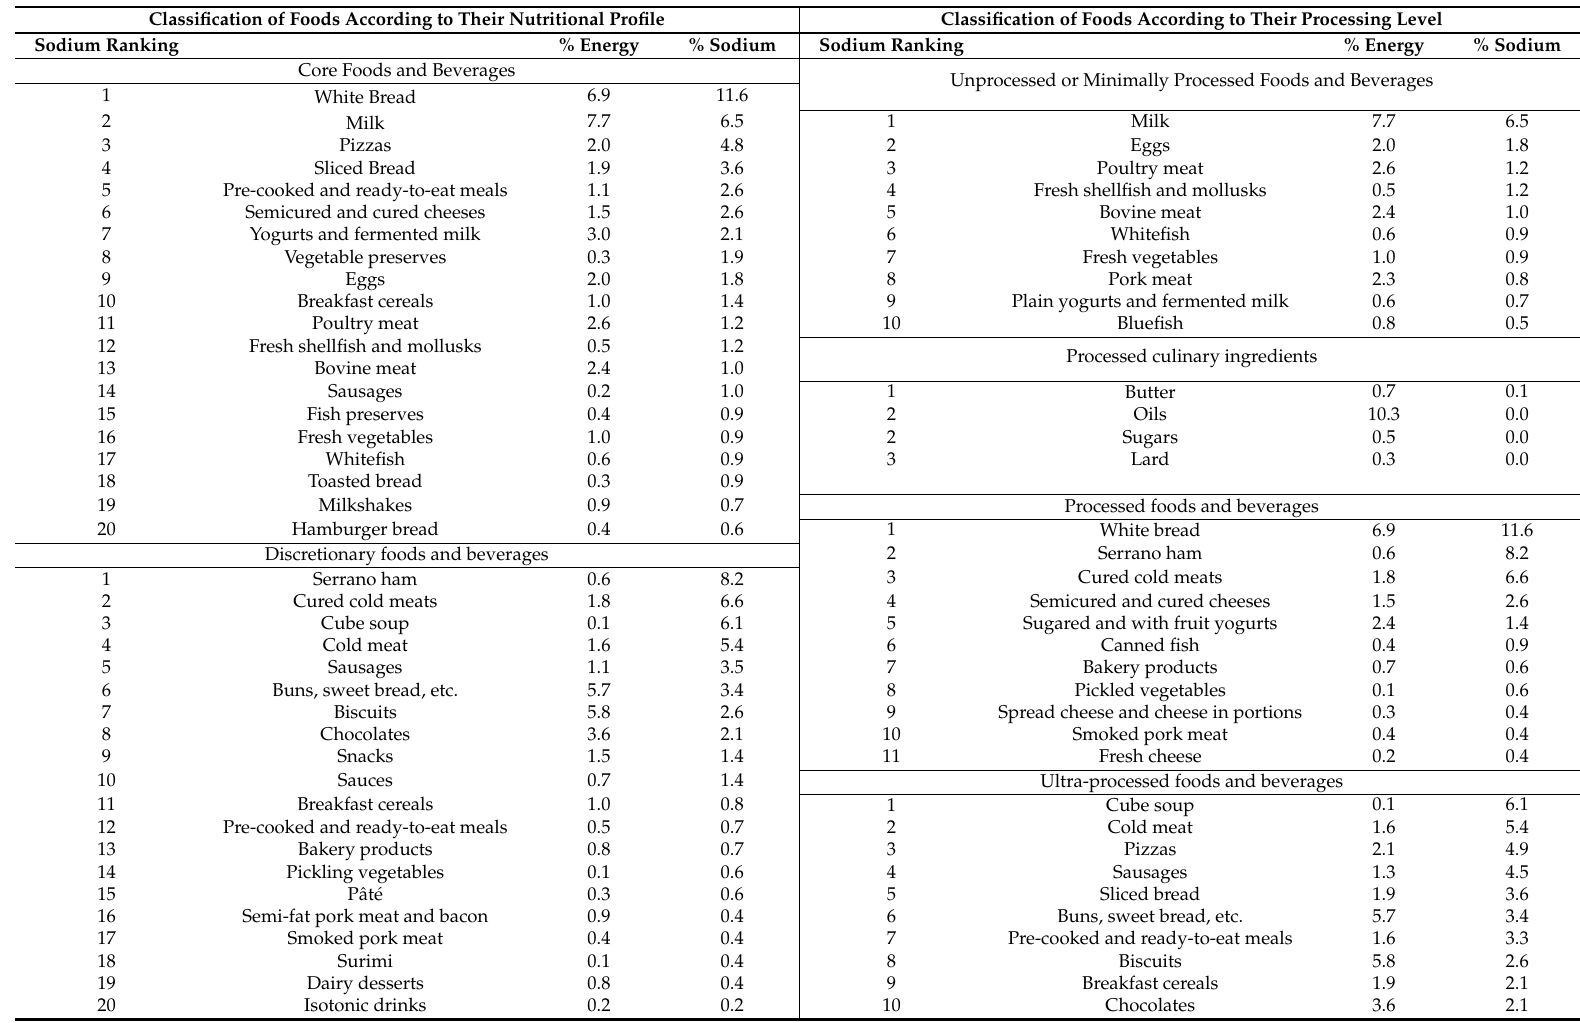
Table 4. Contribution to energy and dietary sodium intake (%) based on the food subgroups by their nutritional profile and their processing level. Classification of Foods According to Their Nutritional